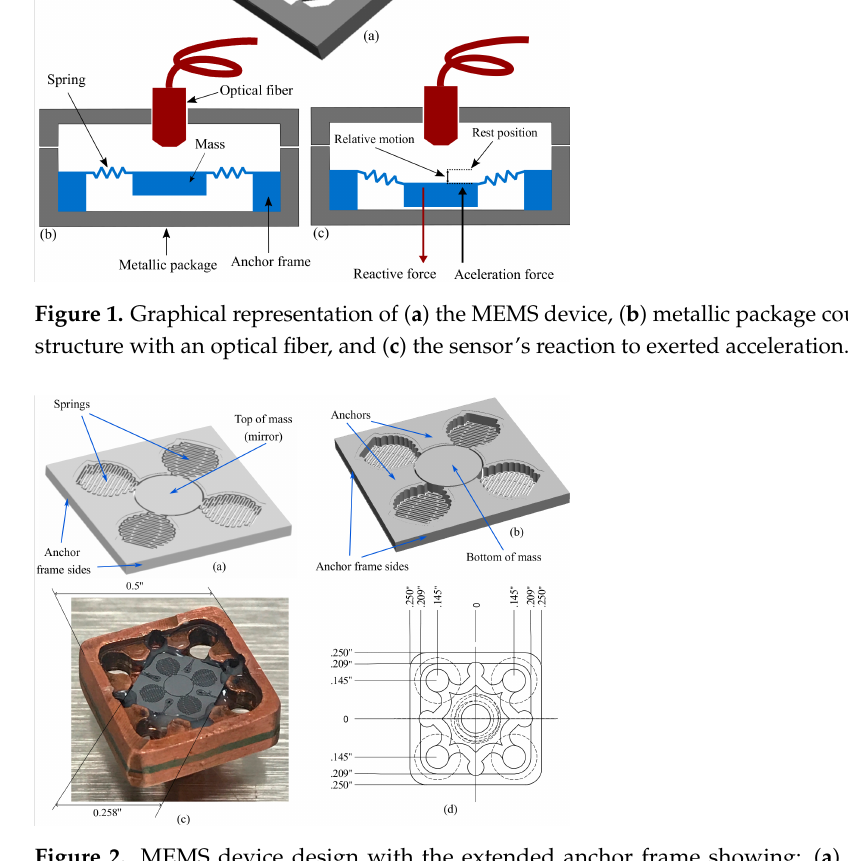
Figure 2. MEMS device design with the extended anchor frame showing: ( a ) the front/mirror side, ( b ) back/mounting side, ( c ) fabricated MEMS structure attached to the metallic package, and ( d ) dimensions of the metallic package.